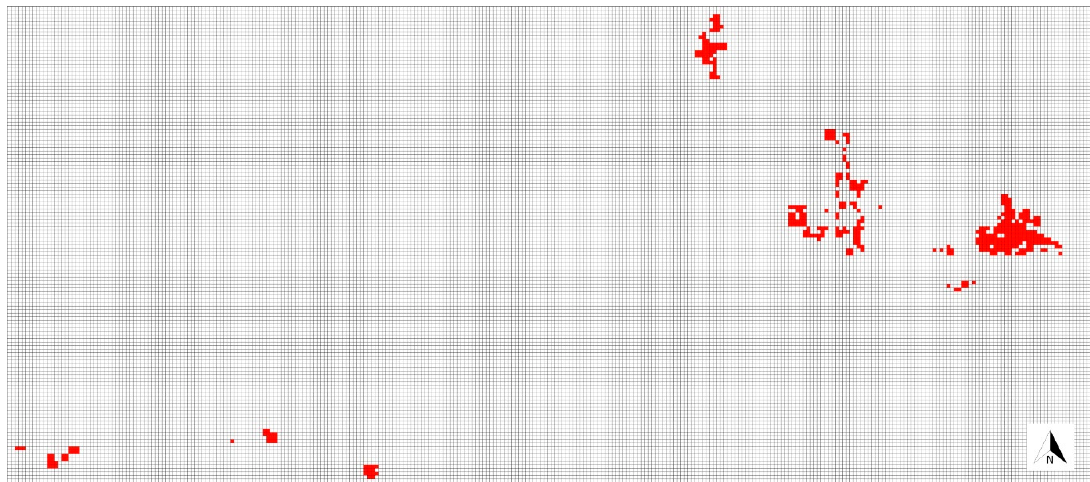
Figure 10. Overview of the spatial distribution of patches in the studied population based on the rectangular grid with a resolution of one square metre. Quadrants of 1 × 1 m where S. brachyodon was detected are filled with red color. Three well defined groups of patches can be recognized (northern, central, and eastern) while in the southwest part of the population several smaller groups of patches can be found.